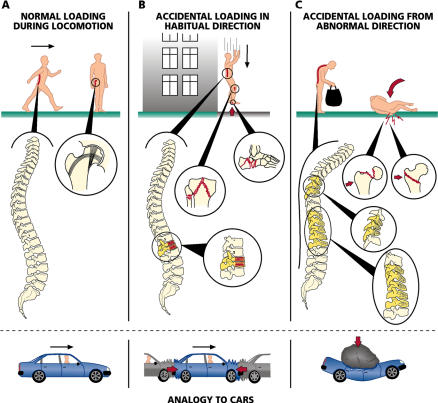
Bone Fractures, Car Accidents, and Direction of ImpactAnalogous to automobiles designed to run on their wheels, the human skeleton is adapted to bipedal gait and the resulting habitual locomotive loadings (Figure 1A). In terms of safety, the design of cars is optimized to keep the driver and passengers in the cockpit intact during collisions from the typical directions of impact, the front or rear (Figure 1B). However, a similar or even smaller force can cause profound damage to the cockpit if it comes from an atypical (unforeseen) direction (Figure 1C). Analogously, the capacity of the skeleton to resist fractures during accidents is generally good when the loading caused by a traumatic incident is a moderate magnification of the loading experienced during habitual activities (i.e., within the inherent safety margin of bone), except in some cases where the incident force exceeds the bones' capacity to withstand the loading without structural failure (Figure 1B). In many cases of older adults' fractures, however, the incident loading in terms of direction, rate, and magnitude is essentially different from the loading that bones are adapted to (Figure 1C). Such cases can be caused, for example, by careless lifting of a shopping bag with straight knees [42,48] or a sideways fall directly onto the hip [26,30].